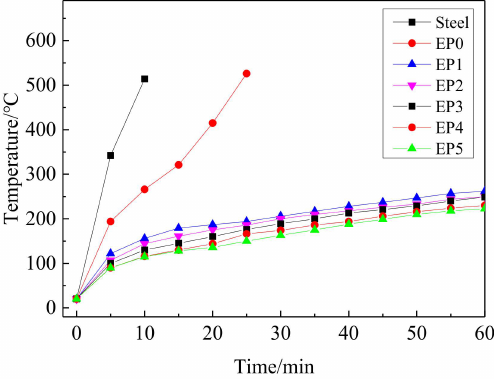
Figure 4. Back-temperature of EP curves for flame-retardant coatings.